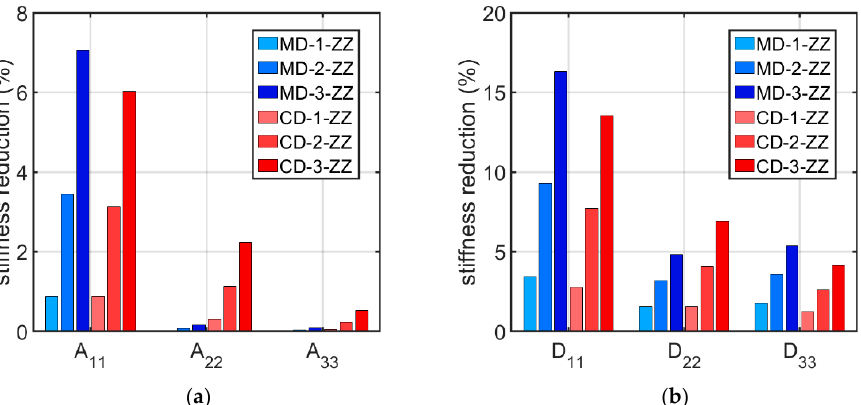
Figure 8. Average percentage stiffness reduction in ( a ) tensile stiffnesses and ( b ) bending stiffnesses. As can be seen in Tables 4–10 and Figure 7, the stiffnesses vary depending on the offset. Considering each set of shape and level of imperfection, the difference between the maximum and minimum stiffness values was calculated. Then, the obtained difference was related to the average stiffness obtained from all 10 offset cases, obtaining a percent- age relative spread. In Table 11, the relative spread for all analyzed sets of imperfection is presented.